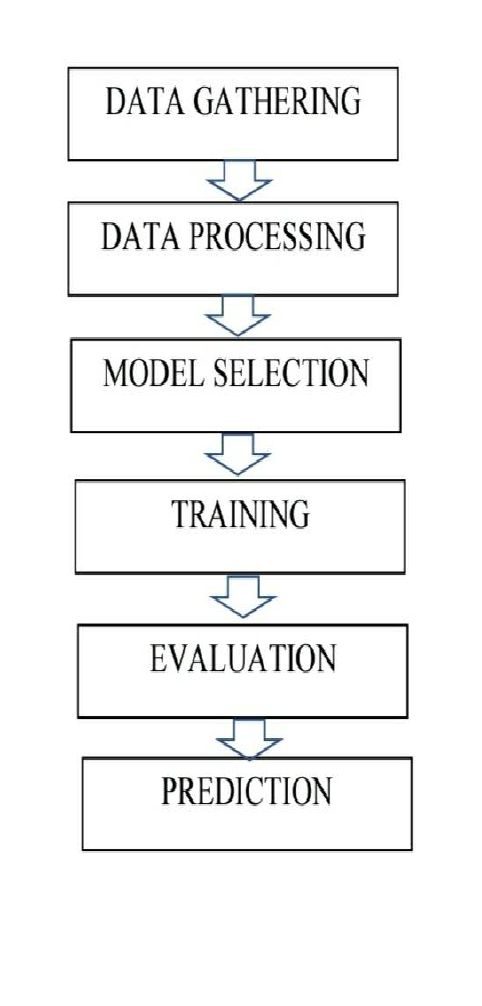
Fig. 1. Contraflow diagram